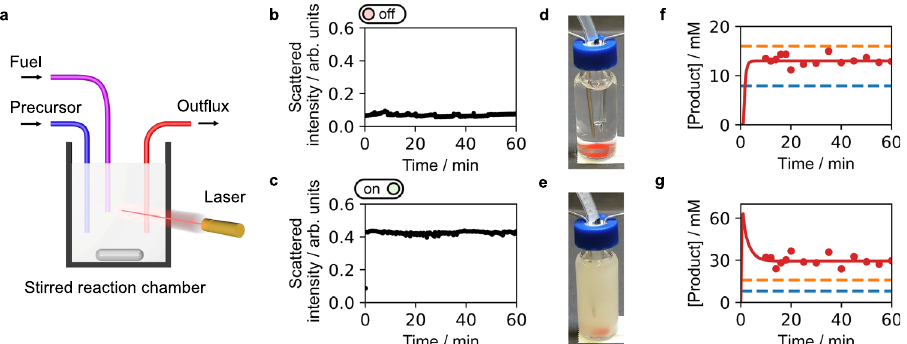
Fig. 2 Chemically fueled assemblies that exert feedback result in bistability. a A schematic representation of our experimental setup to keep the product in a steady state concentration. Precursor and fuel are added continuously to a stirred reaction chamber and all the reaction cycle ’ s components are removed by an out fl ux. b , d and f The off-state was created when a 1.5 ml reactor was supplied with 25 mM.min − 1 EDC and 30 mM.min − 1 precursor with a space velocity of 0.4 min − 1 . We con fi rmed the absence of crystals by ( b ), turbidity and ( d ), a photograph and we measured the steady state concentration by ( f ), HPLC. c , e and g The same experiment as above, but now an 80 mM EDC spike was added in the beginning. The markers in the concentration plot correspond to HPLC data, whereas the red line shows a prediction by our kinetic model. The blue and orange lines are the S out and S sat